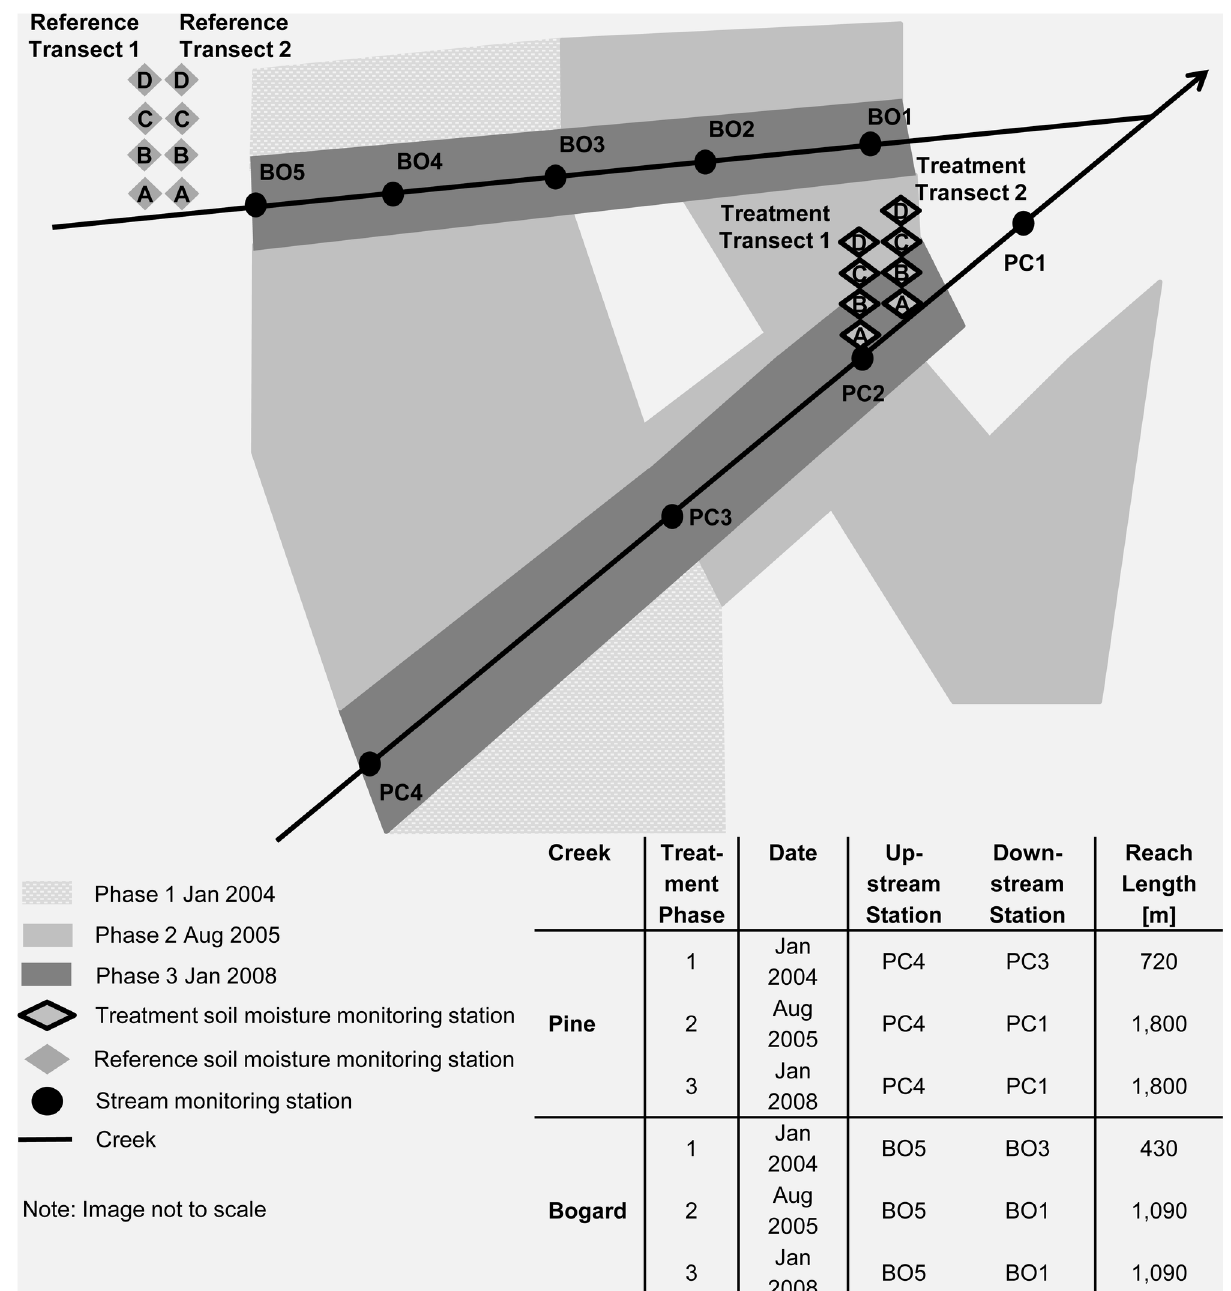
Figure 2. Illustration of Pine-Bogard Project Phases 1-3 treatment areas and stream and soil monitoring station